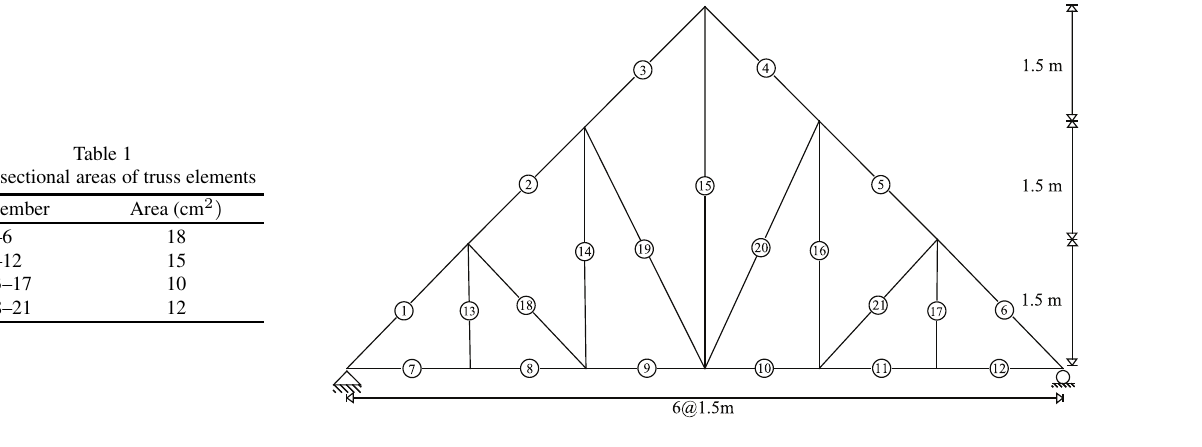
Fig. 6. Geometry of Belgian